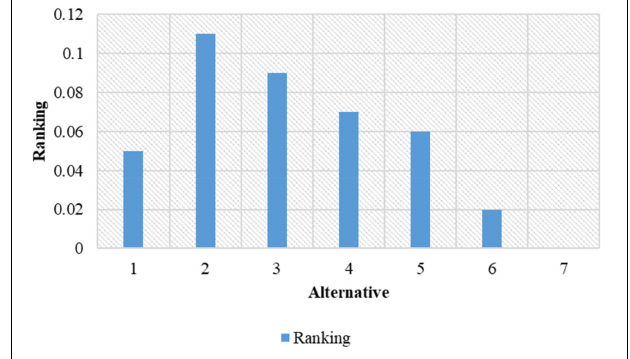
FIGURE 13 | Overall ranking for the prioritization